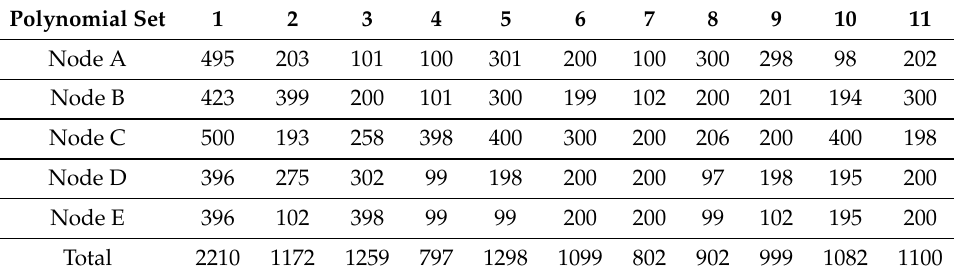
Table 2. Successful transmissions per node for each polynomial